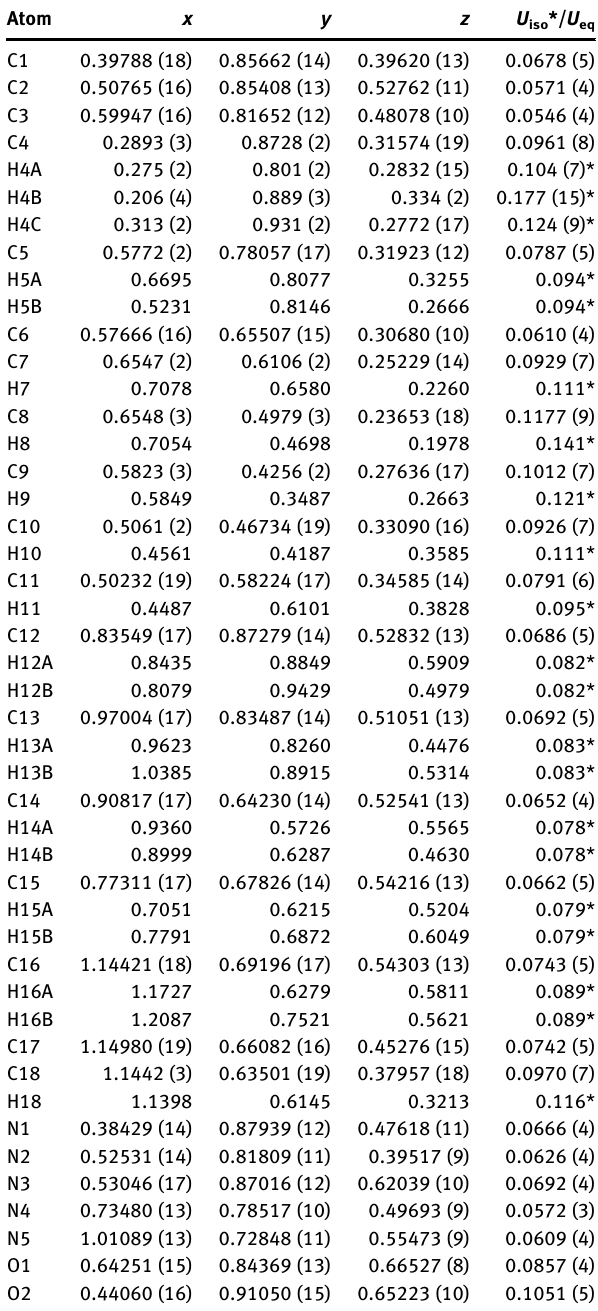
Table  : Fractional atomic coordinates and isotropic or equivalent isotropic displacement parameters (Å 